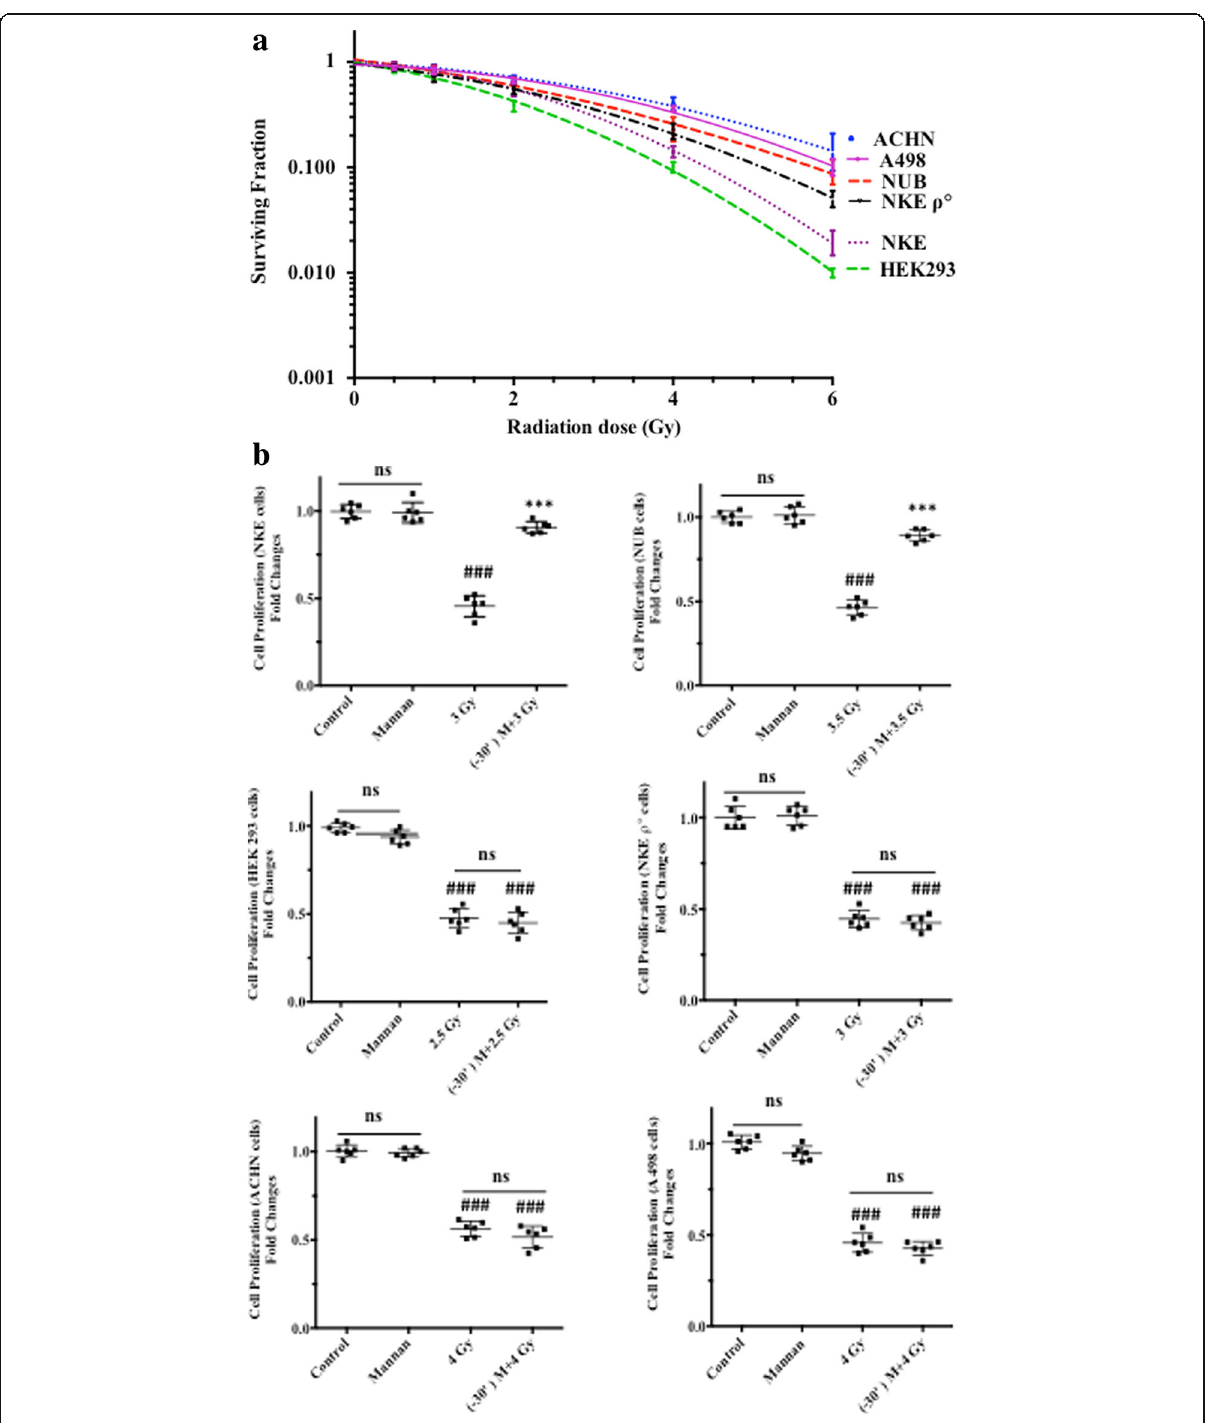
Fig. 8 (See legend on next